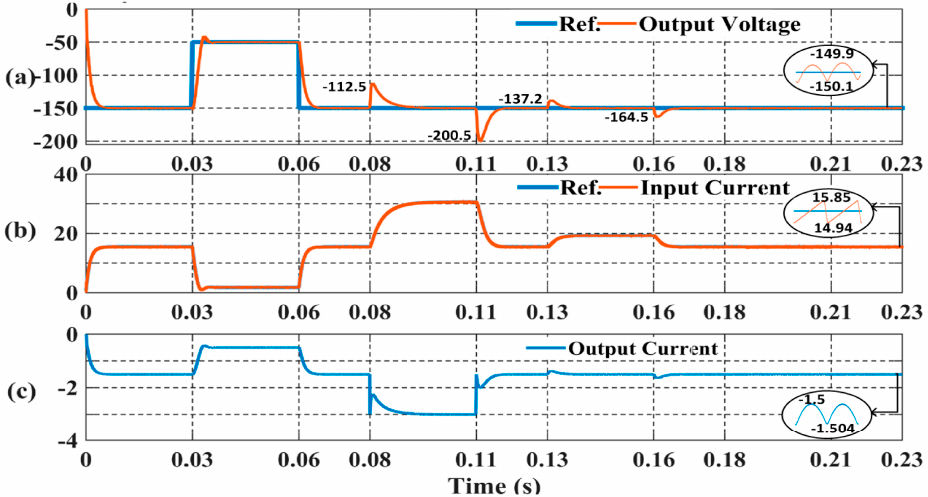
Figure 9. Performance of proposed equivalent controller. ( a ) Output Voltage (V); ( b ) Input Current (A); ( c ) Output Current